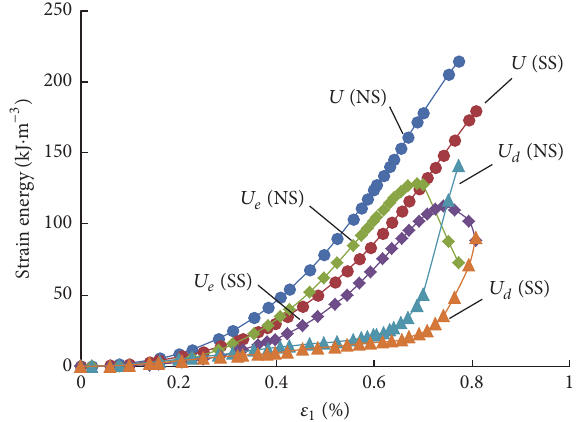
Figure 6: Comparison of energy conversion curves under natural and saturated states.